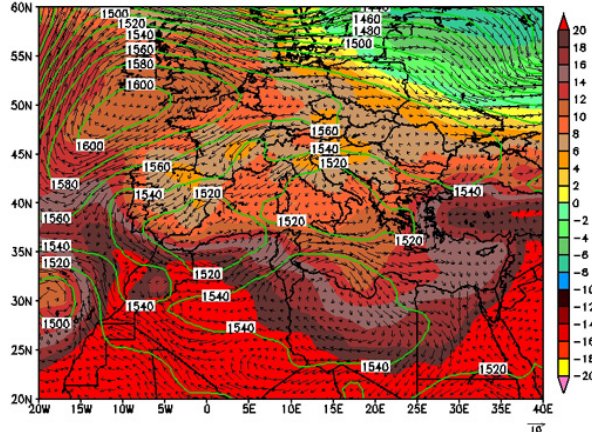
Fig. 4. Temperature ( ◦ C, shaded), wind (arrows) and geopoten- tial height (gpm, contoured) at 850hPa on 11 October 2007 at 12:00UTC obtained from NCEP Reanalysis